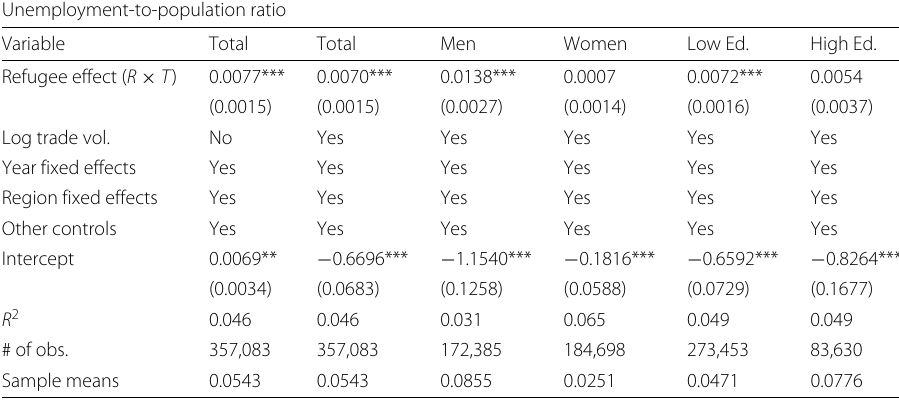
Table 7 Unemployment-to-population ratio Unemployment-to-population ratio